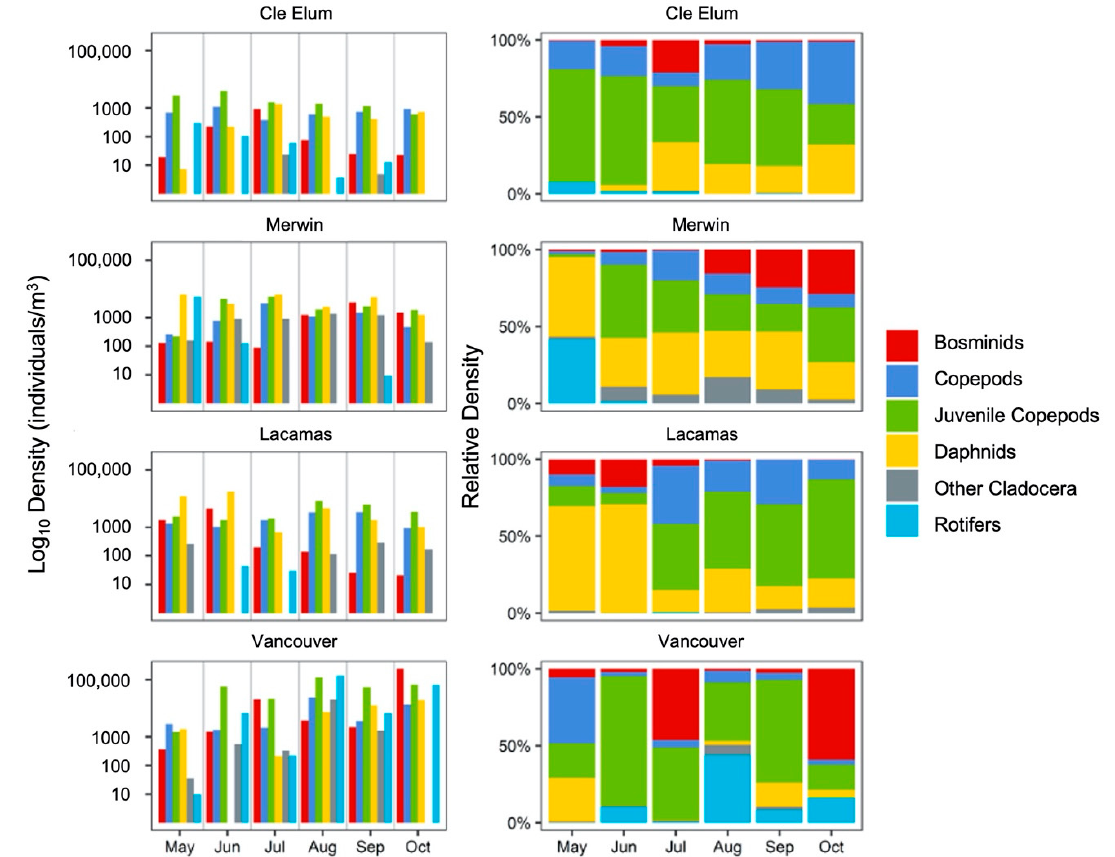
Figure 5. Zooplankton absolute abundance (shown on a log 10 scale, in left panels) and relative abundance (in right panels), binned into five major taxonomic categories, in monthly samples from Cle Elum, Merwin, Lacamas, and Vancouver lakes from May through October of